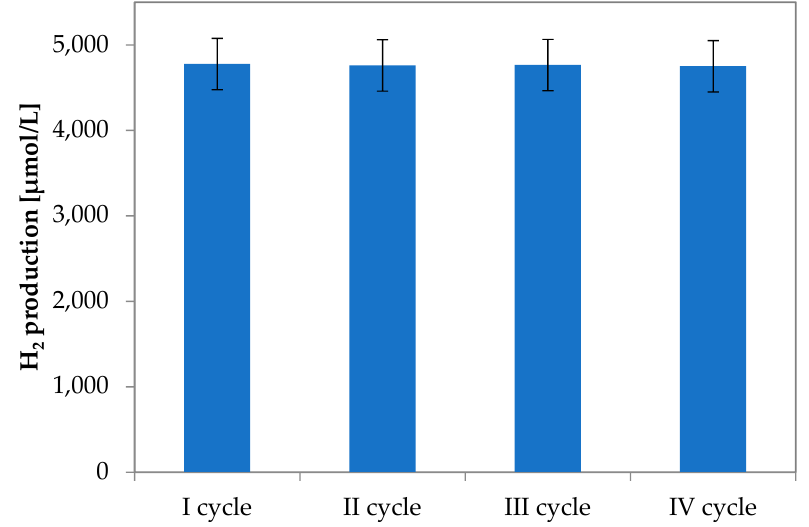
Figure 7. Evaluation of hydrogen production after 4 h of irradiation on the 1.08Cu_ZnO catalyst for different cycles. Initial glycerol concentration 10 wt %; UV light intensity: 32 mW/cm 2 .